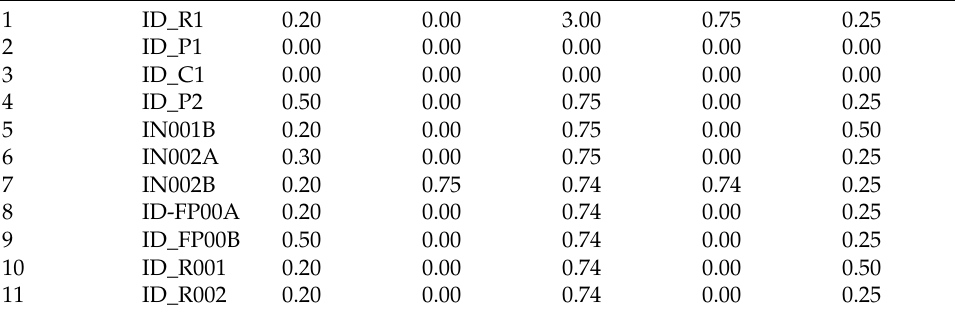
Table 13. Subtasks time of product B of the Polymer plant, structuring seven columns: Task number, Unit_ID, Preparation time, Load time, Operation time, Unload time, and Cleaning